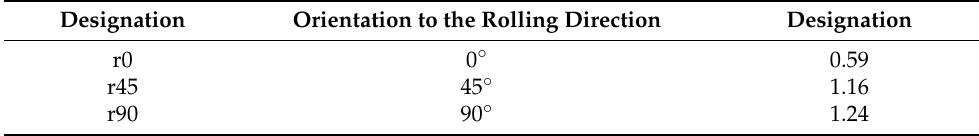
Table 2. Average r-values for 1.4404 with a thickness of 0.05 mm [Vitesco Technologies Group AG].